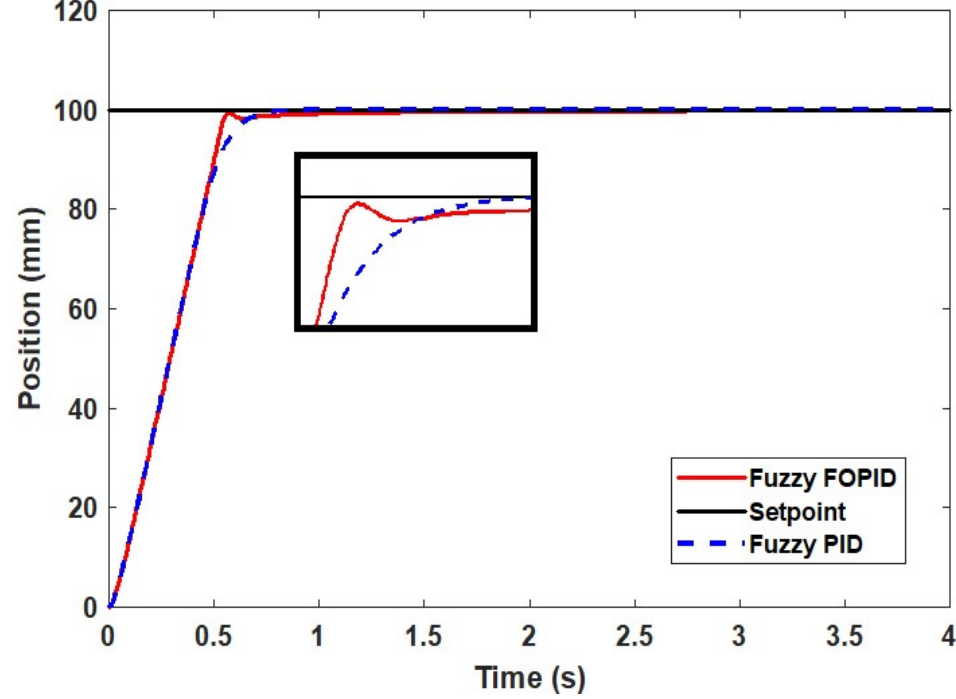
Figure 23. Dynamic response of the system with the fuzzy FOPID and fuzzy PID controllers under parametric uncertainties, case 3.